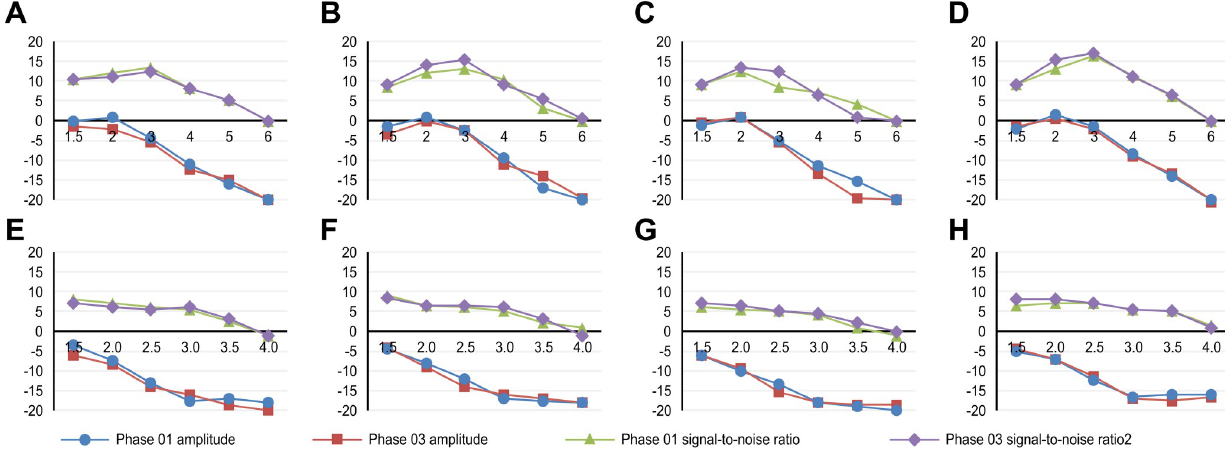
Fig 2. Parameters in distortion products and transient otoacoustic emissions in the caffeine and placebo groups. A- DPOAE for the right ear in the caffeine group; B- DPOAE for the right ear in the placebo group; C- DPOAE for the left ear in the caffeine group; D- DPOAE for the left ear in the placebo group; E- TEOAE for the right ear in the caffeine group; F- TEOAE for the right ear in the placebo group; G- TEOAE for the left ear in the caffeine group; H- TEOAE for the left ear in the placebo group.